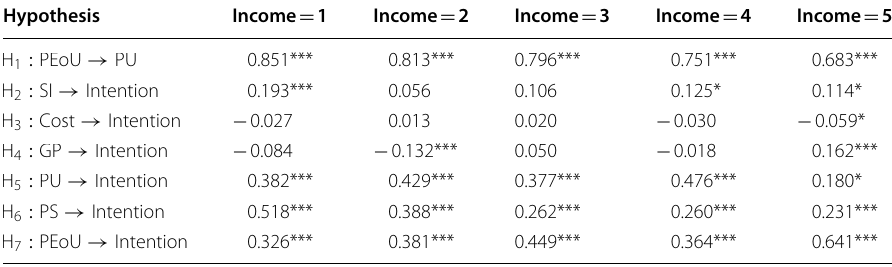
*** p value < 0.001 Table 9 The impact of income on e-cash